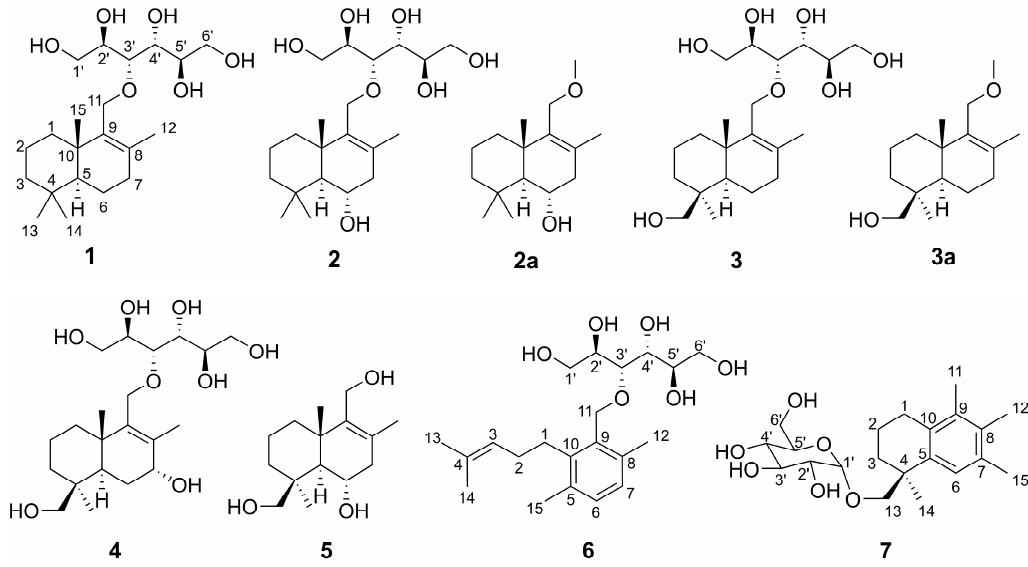
Figure 1 . The structures of 1 – 7 Figure 1. The structures of 1 – 7